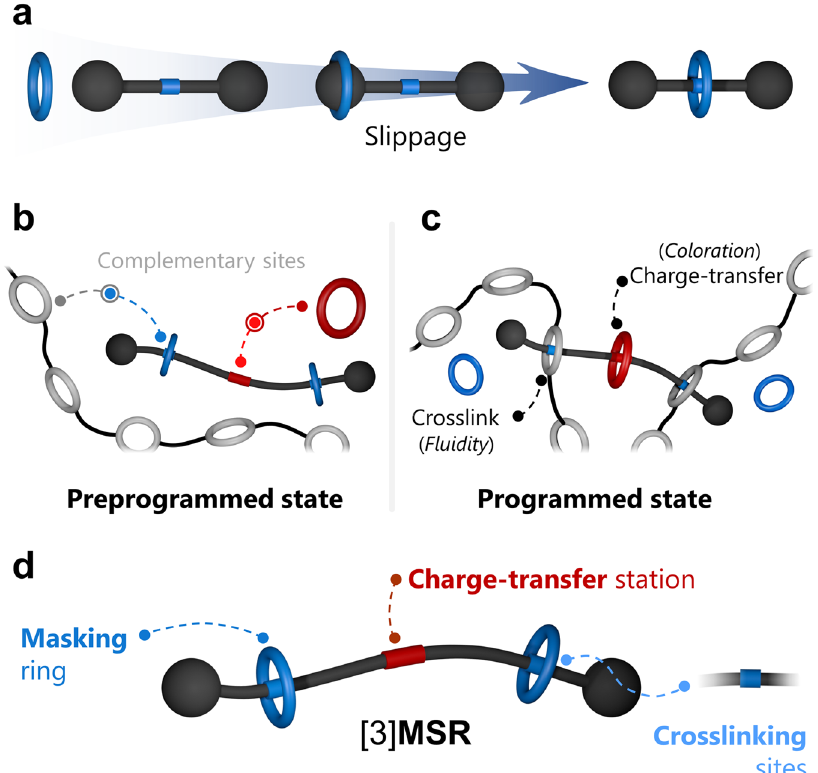
Fig. 1 Metastable rotaxanes to produce supramolecular gels with a color indicator. Cartoon representation of a rotaxane assembly through the slippage approach, b a preprogrammed system containing complementary elements, c a programmed self-assembled supramolecular network, and d [3] MSR comprising one dumbbell molecule and two